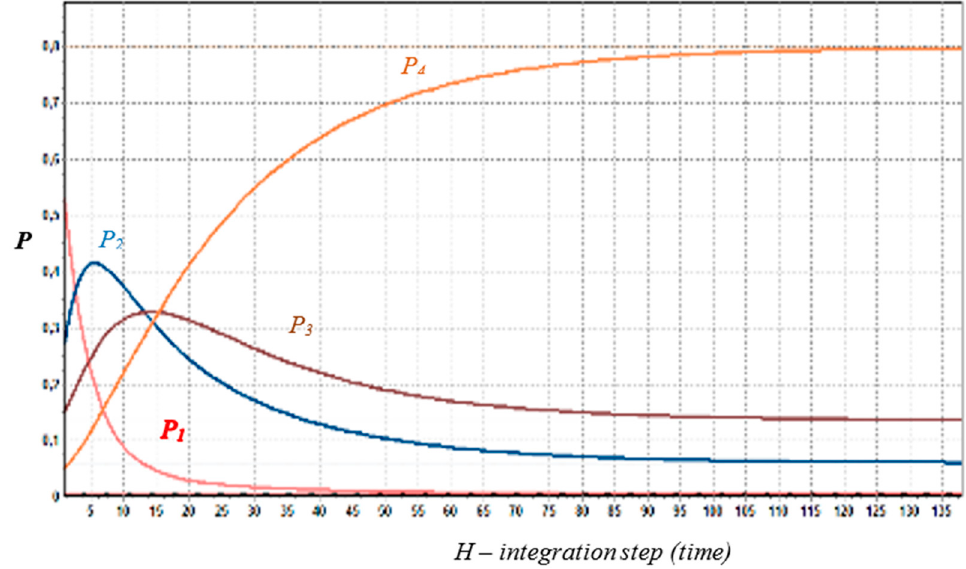
Figure 4. Probability characteristics of the development states of employees of the sanatorium–re ‐ sort complex in